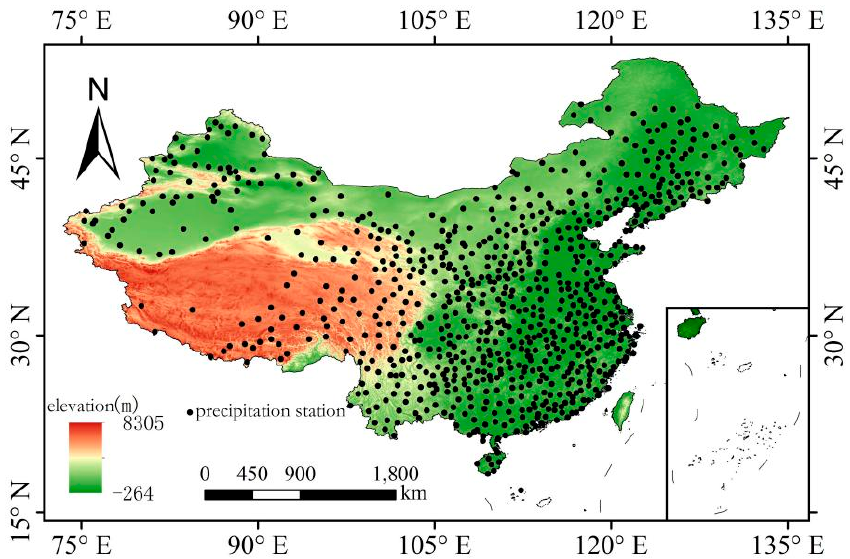
Figure 1. Elevation Model (DEM) data and distribution of the 797 rain gauge stations in mainland China.